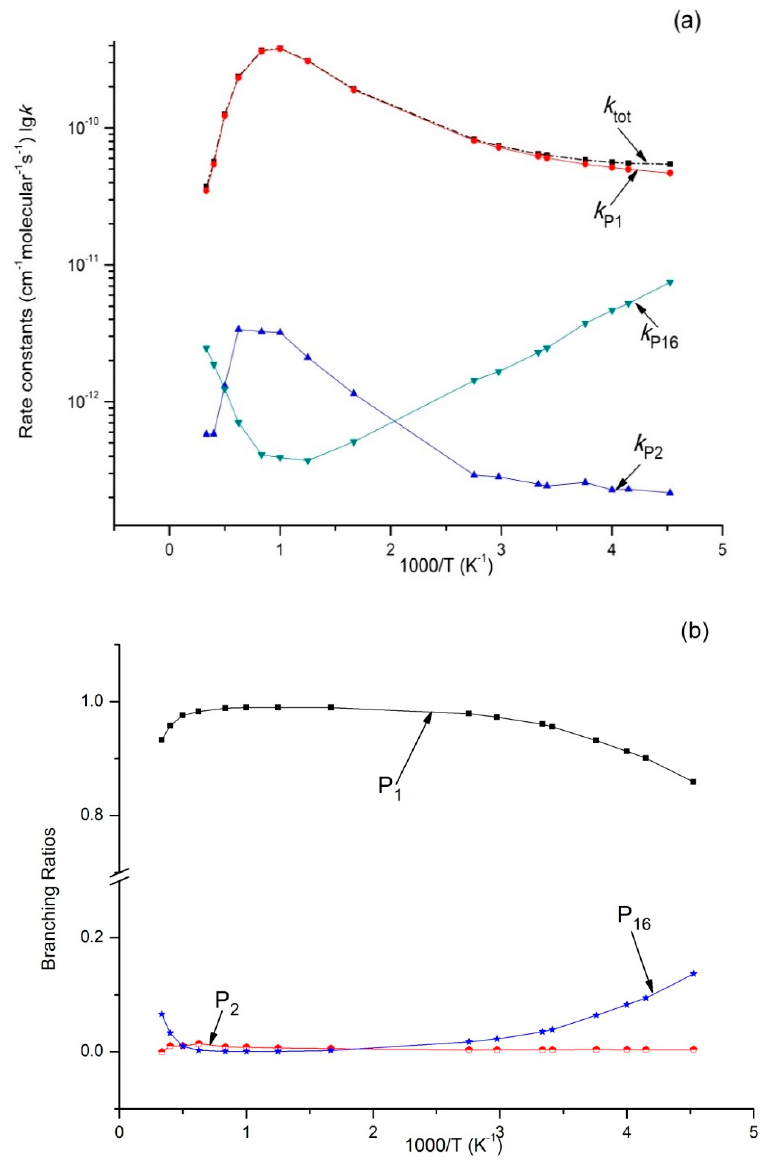
Figure 5. ( a ) Rate constants of total ( k tot ) and various reaction channels ( k P1 , k P2 , k P16 , and k IM1 ) at 1 bar in a temperature range of 220 K to 3000 K; ( b ) Branching ratios of various reaction channels at 1 bar in a temperature range of 220 K to 3000 K.